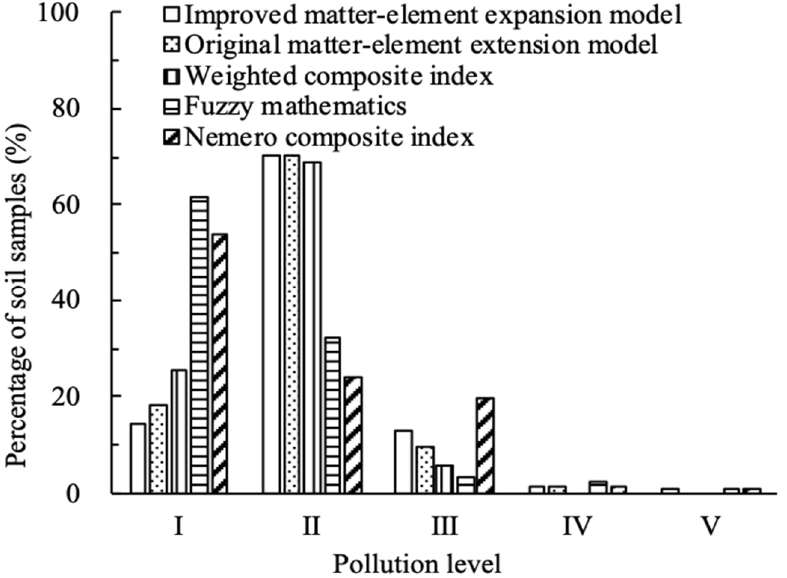
Figure 4. Percentage of soil samples with various pollution levels based on five different evaluation